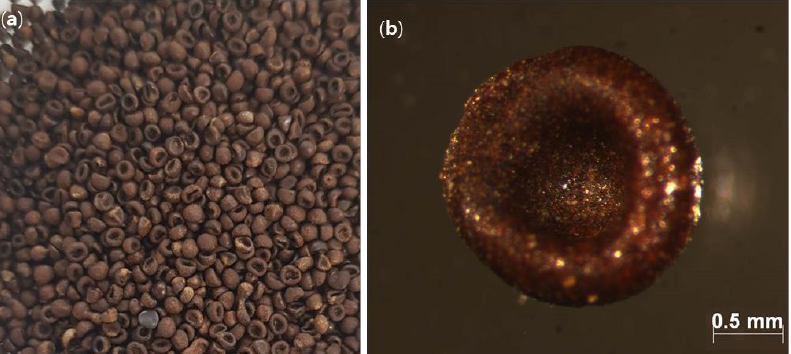
Figure 3. Images of the dried SCM beads: ( a ) photo and ( b ) micrograph (×25). A field emission scanning electron microscope (FE-SEM, SU8220, Hitachi, Japan) and